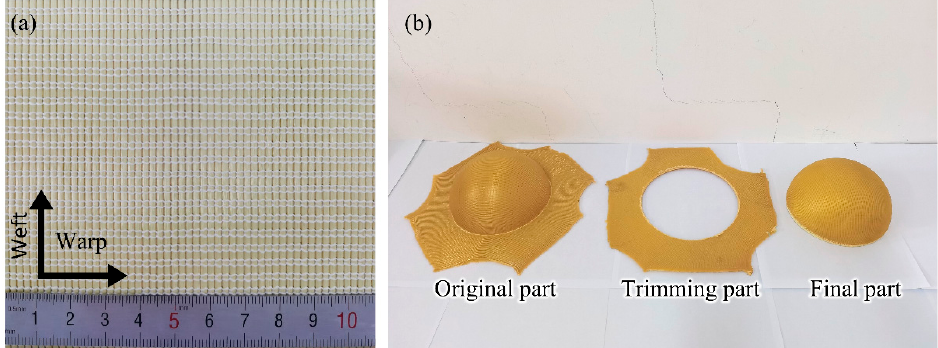
Figure 1. BWK fabric and composite specimens: ( a ) BWK fabric; ( b ) composite sample.